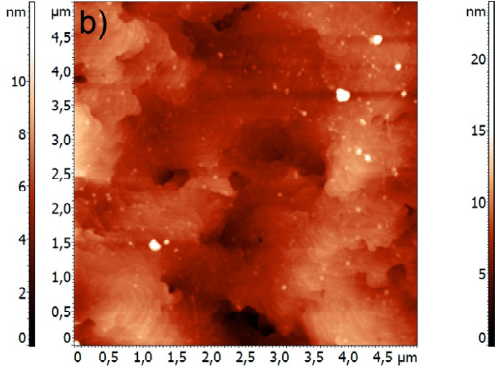
Fig. 2. AFM topography images of samples (a) A and (b) C on the scale 5x5  m 2 as well as (c) A on the scale 2x2  m 2 clearly visualizing V-defects as small dark